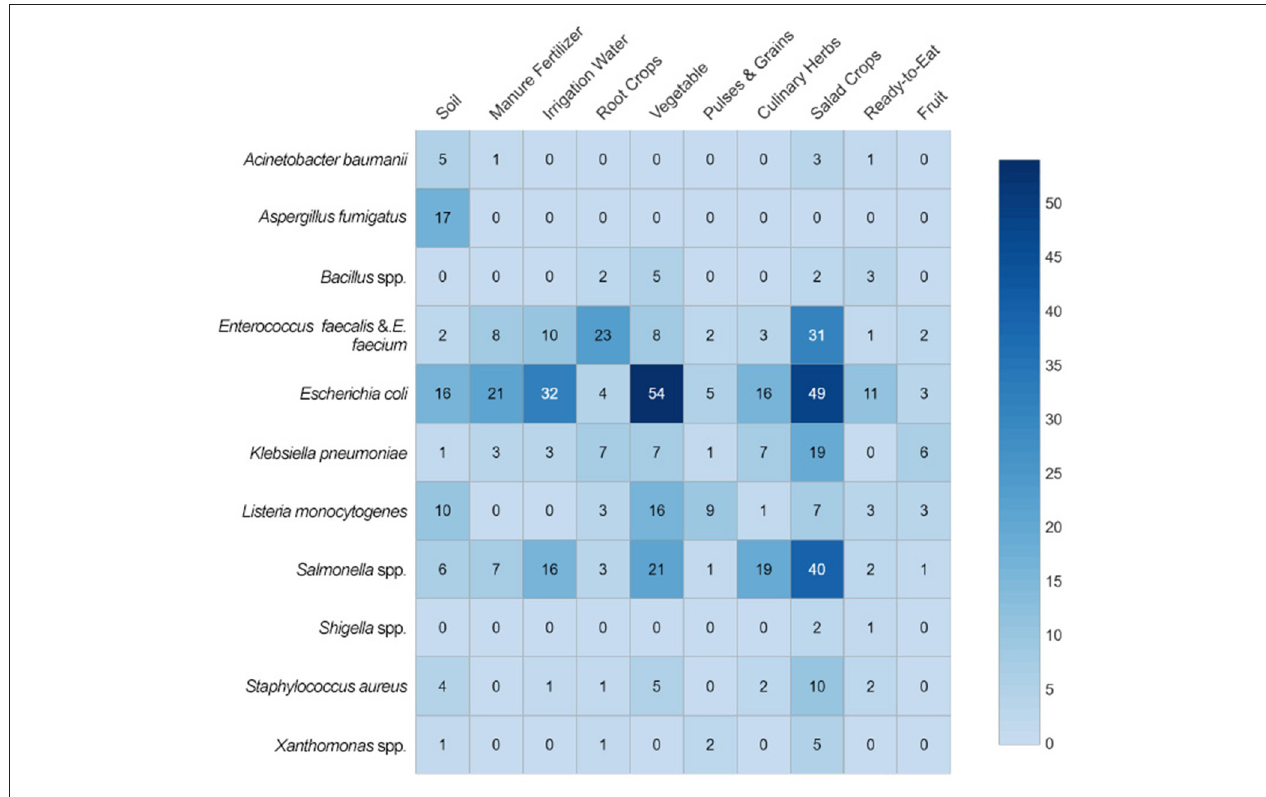
FIGURE 2 | Microbial isolates of sample groups reported in studies published between 2000 and 2020. In this heat map, shaded cells indicate the distribution of microbes of interest isolated from sample groups reported in 196 studies, with the number of observations of microbe isolates per sample group indicated in the cell. Studies could report multiple isolates from multiple sample groups, so the number of observations is not equal to the number of studies.